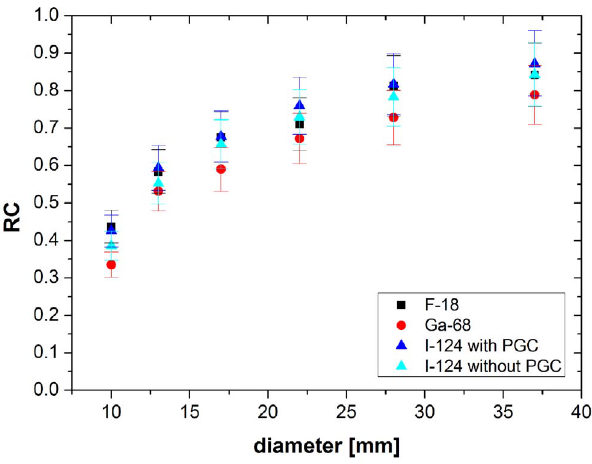
Figure 4. RC of F-18, Ga-18 and I-124 with and without PGC as a function of sphere diameter. Reconstruction iterative with scatter correction and a Gauss-filter with a FWHM of 2 mm and a S:BG < 10:1.